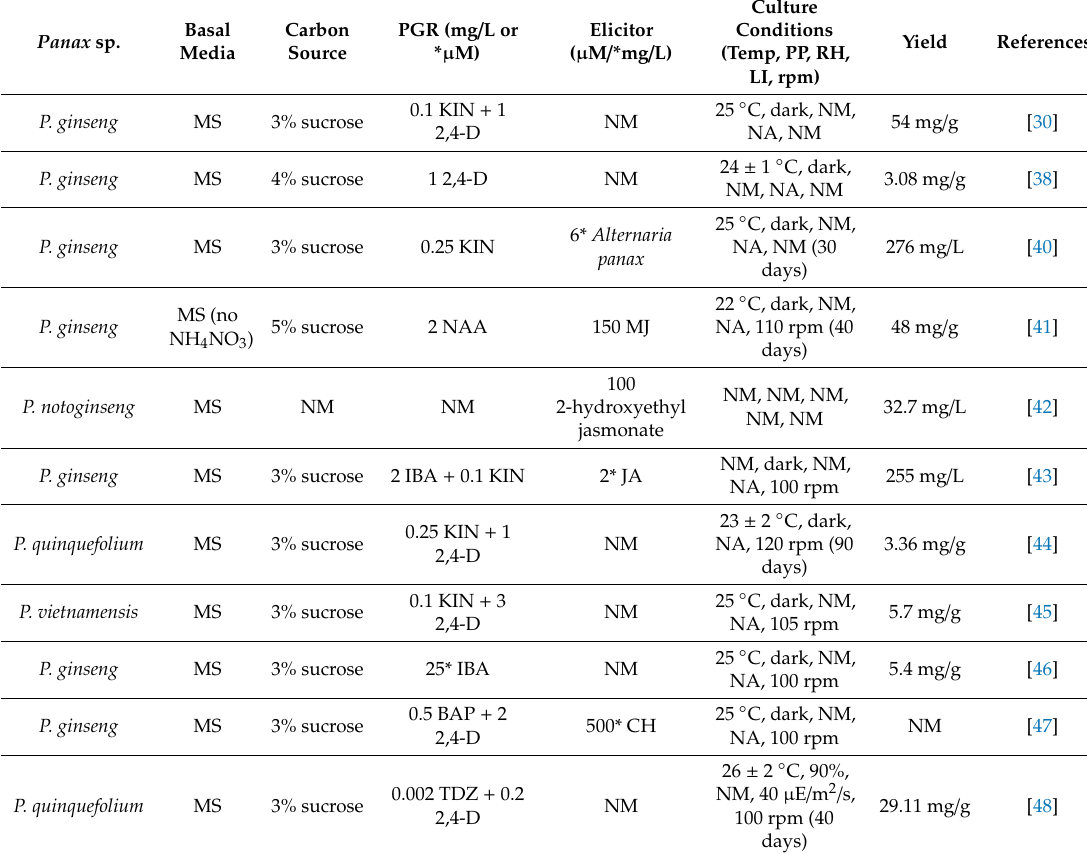
Table 2. Factors involved in and their influence on ginsenoside production in cell suspension culture. Basal Panax sp.